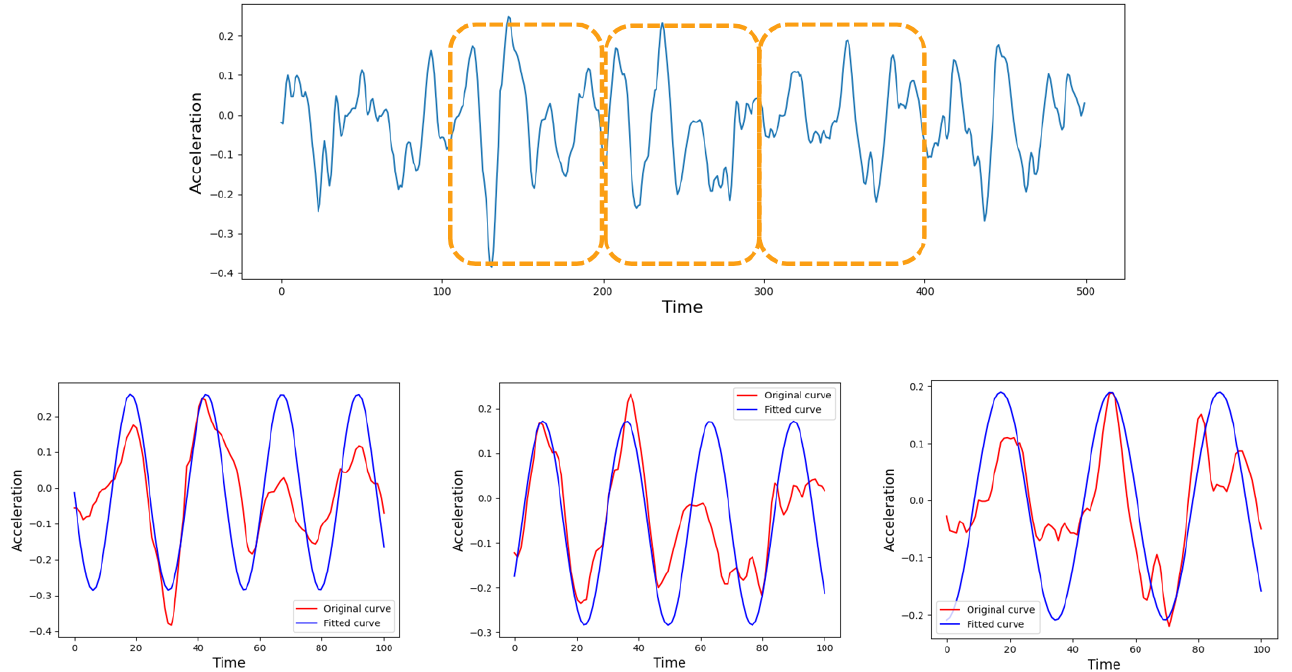
Figure 7. Fitting curve of feature vectors by FFT.